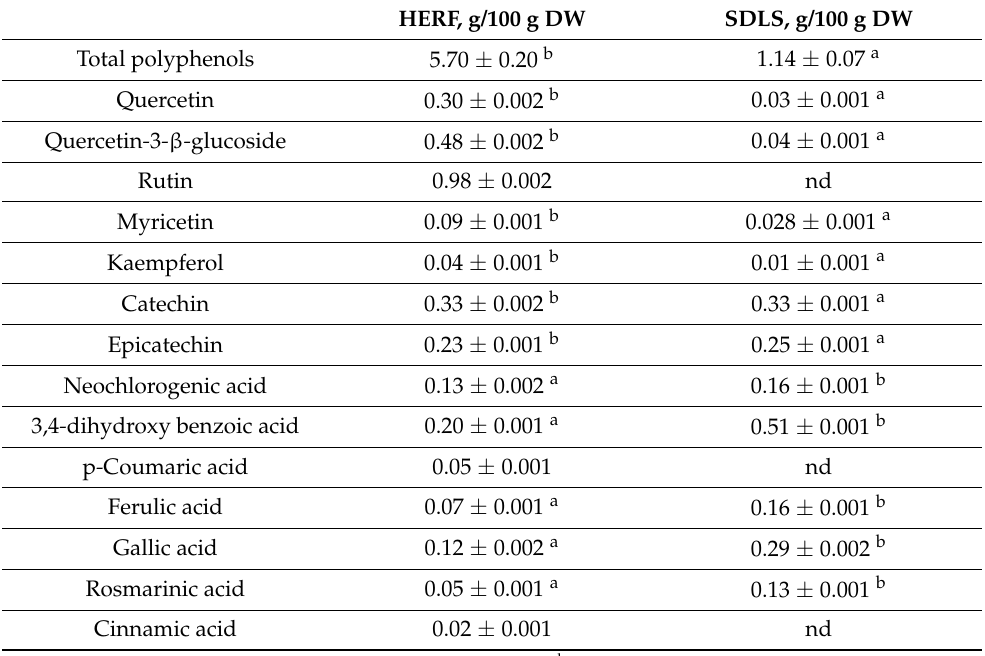
Table 2. Total polyphenol content, individual flavonoids and phenolic acids in hexane extracted rose flowers (HERF) and steam distilled lavender straw